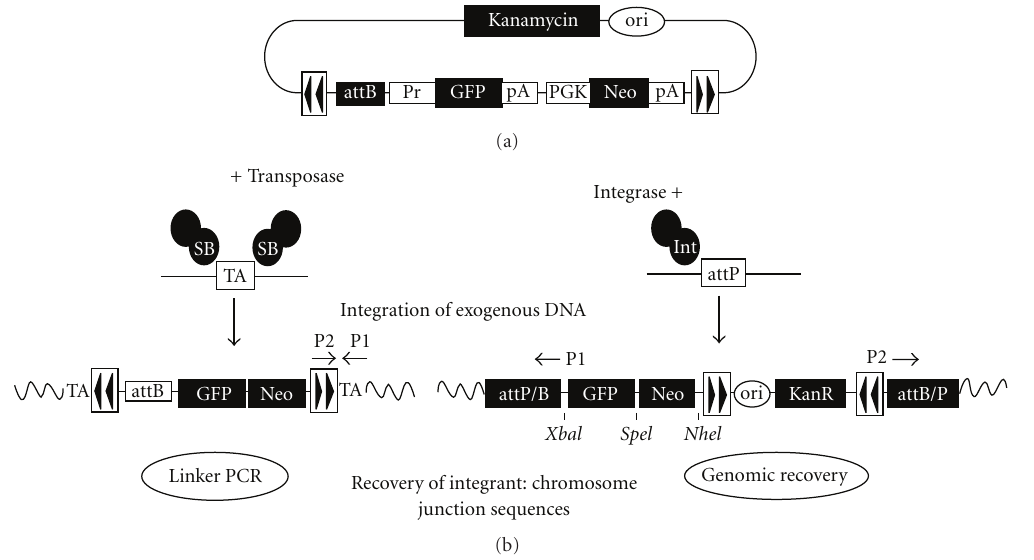
Figure 1: Schematic diagram of the internally controlled pKT2/NAG vector and integration products mediated by Sleeping Beauty (SB) transposase and by bacteriophage PhiC31 ( φ C31) integrase. (a) The integrating vector consists of (i) a φ C31 integrase recognition site ( attB ); (ii) eF1 α or CMV- (Pr-) regulated GFP expression unit; (iii) neomycin resistance gene (Neo) transcriptionally regulated by the PGK promoter; (iv) flanking T2 transposase binding sites (IR/DRs; boxes with double triangles) separated by; (v) a colE1 bacterial origin of replication and kanamycin resistance gene; (vi) pA, polyadenylation signal from the rabbit beta globin gene. (b) SB transposase-mediated integration (left): the SB transposase excises transposon sequences at IR/DR transposase binding sites and precisely inserts them into TA- dinucleotide targets in cellular chromosomes, which are subsequently duplicated. φ C31 integrase-mediated integration (right): exogenous gene sequences on an attB containing plasmid integrate into mammalian genomes at “pseudo- attP ” sites, chromosomal sequences having partial homology to the wild-type phage attP